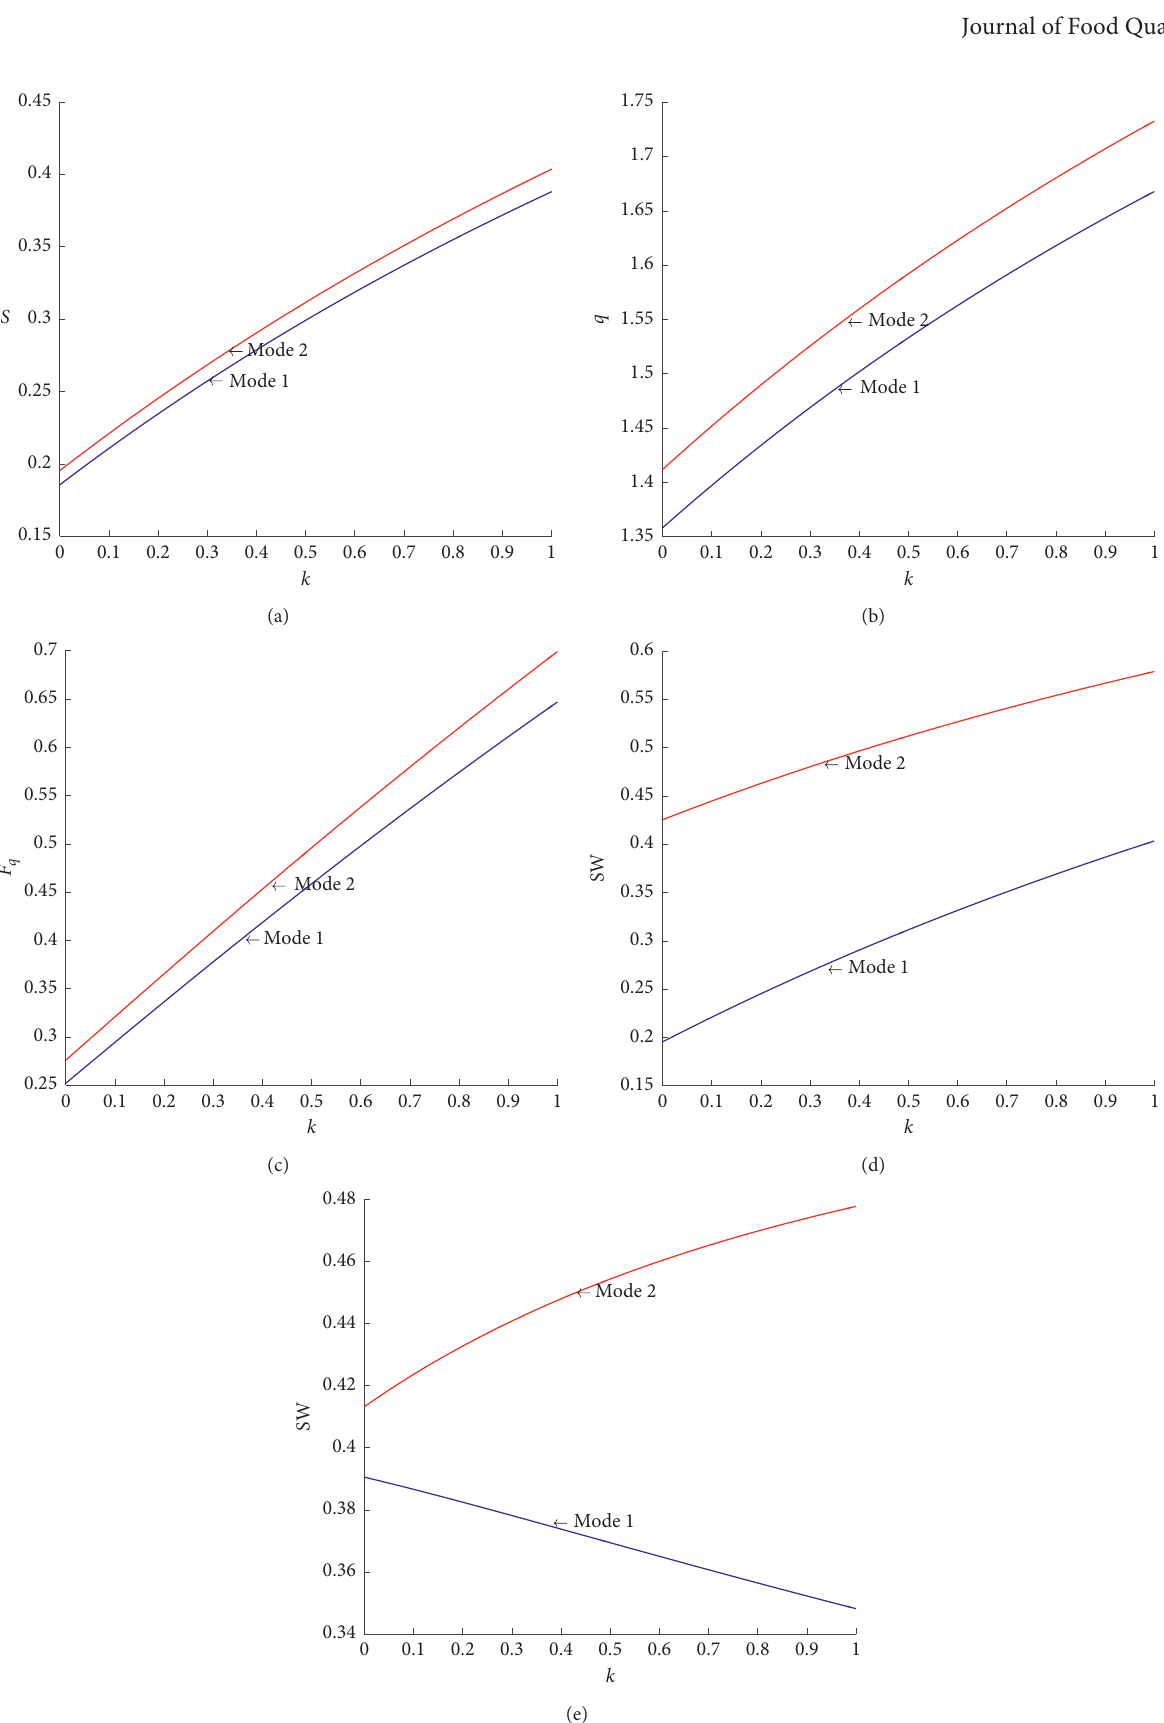
Figure 5: (a) The government subsidy as k changes. (b) The safety investment as k changes. (c) The government expenditure as k changes. (d) The social welfare as k changes when the government decides the subsidy. (e) The social welfare as k changes when S �